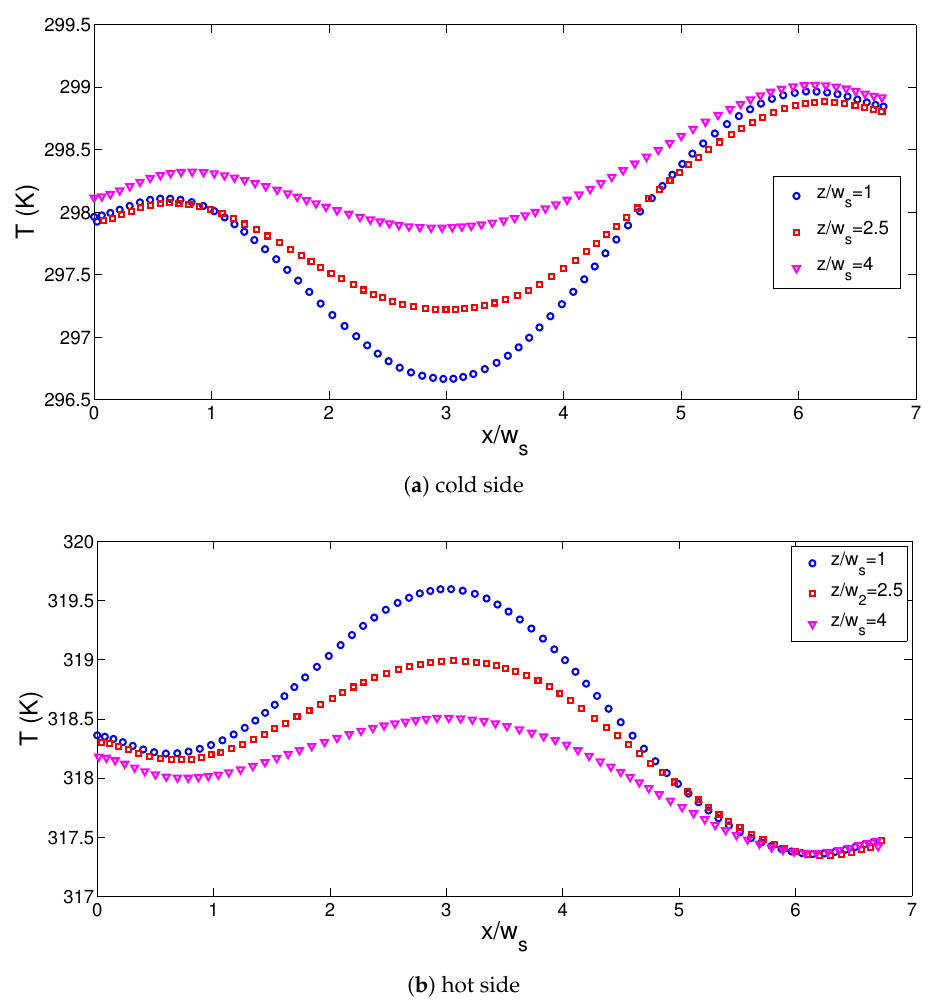
Figure 12. Impacts of distance from the inlet to target surface on the variation of interface tempera- tures at the cold ( a ) and hot ( b ) side ((Re 1 , Re 2 ) = (500, 500), (r 1 , r 2 ) = (1, 1), φ =